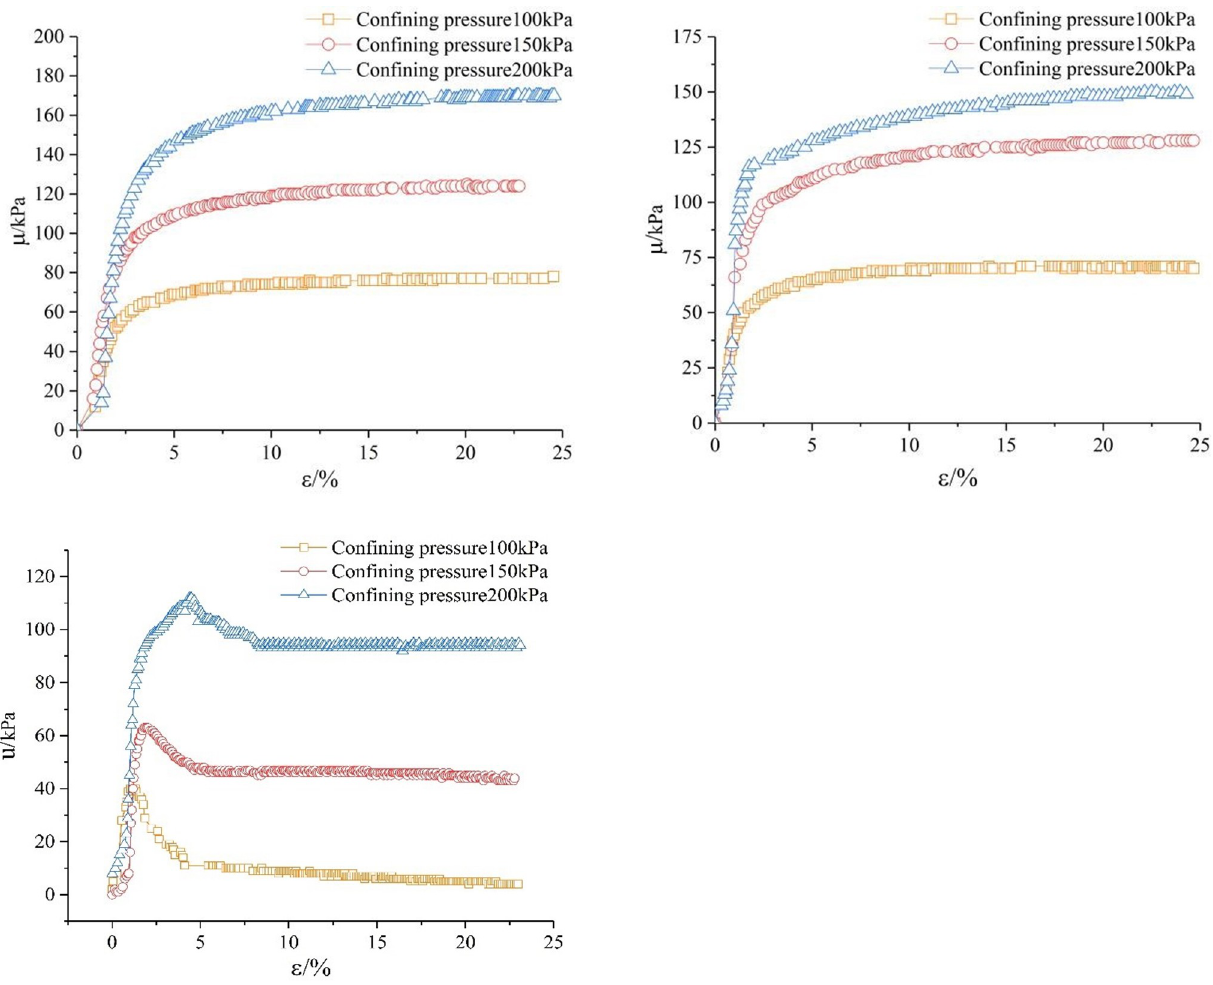
Fig 6. Pore water pressure u curve with shear rate of 0.4mm/min at dry density of 1.5g/cm 3 , 1.6g/cm 3 , 1.7g/cm 3 . (a) ρ d = 1.5 g/cm 3 . (b) ρ d = 1.6 g/cm 3 . (c) ρ = 1.7 g/cm 3 d